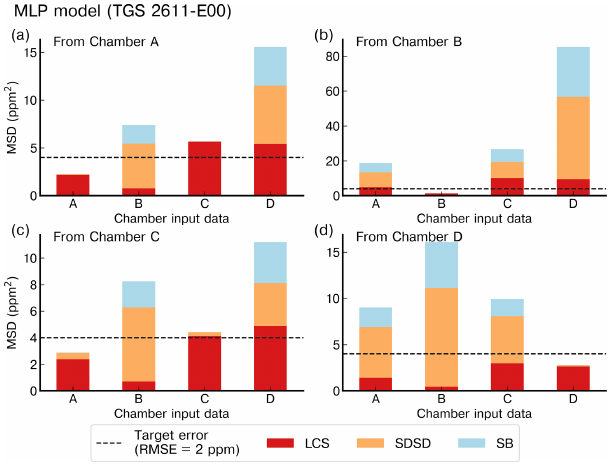
Figure A6. Reconstruction error of the peaks for the MLP model with the TGS 2611-C00 as input and using the best stratified train- ing on (a) chamber A, (b) chamber B, (c) chamber C and (d) cham- ber D. The first column on each panel is the reconstruction error on the test set of the chamber on which the training was done; the other columns are the reconstruction on the whole dataset for that chamber on the same sensor. Note the different ranges of the y axis.